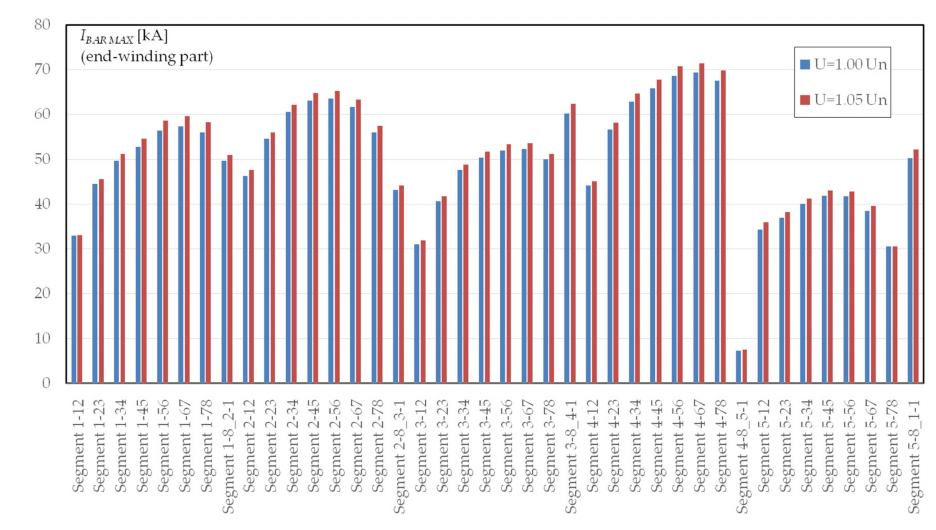
Figure 10. Distribution of maximum values of currents induced in the rotor’s circuited segments at 180° of voltage phase shift.